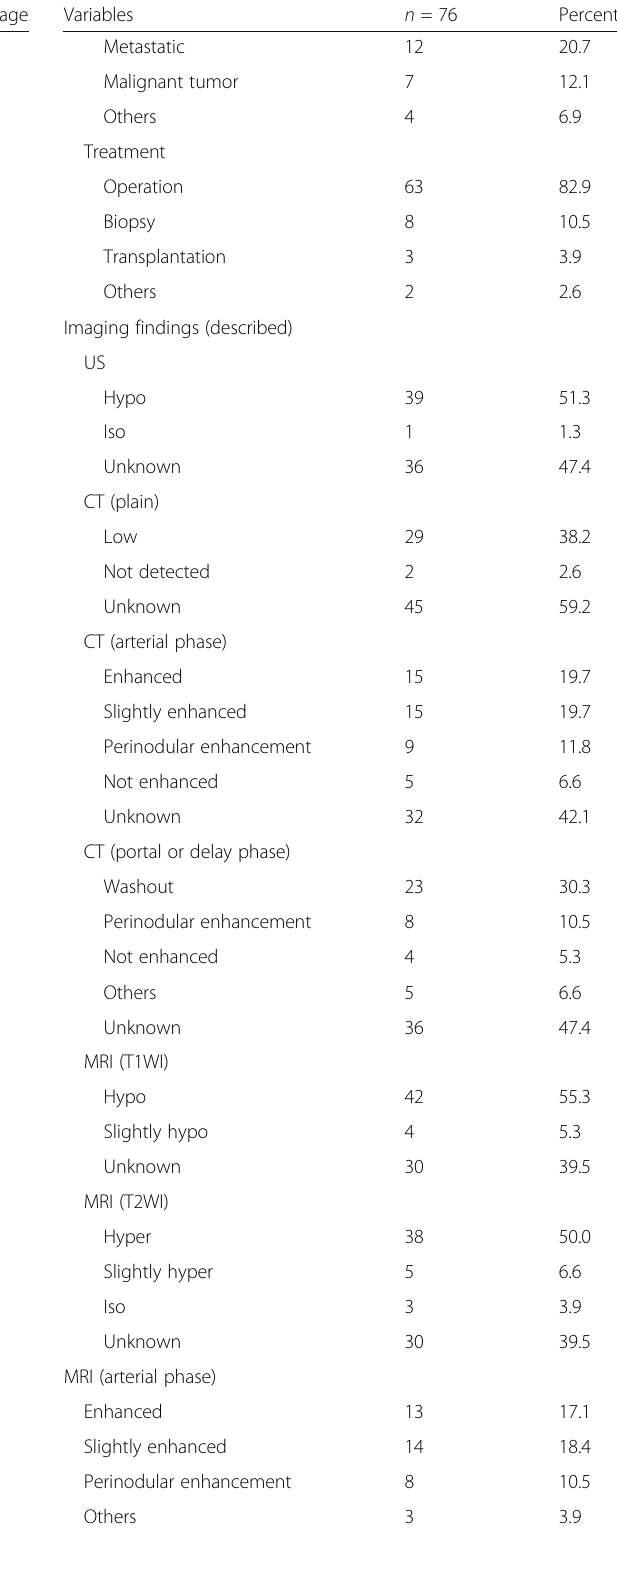
Table 1 Clinicopathological features of reactive